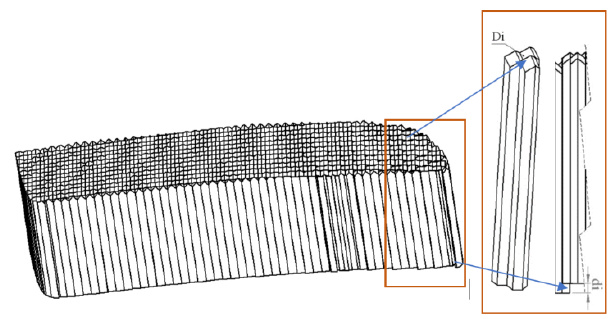
Figure 12. The height difference between the neighboring pins in a double-pin group.